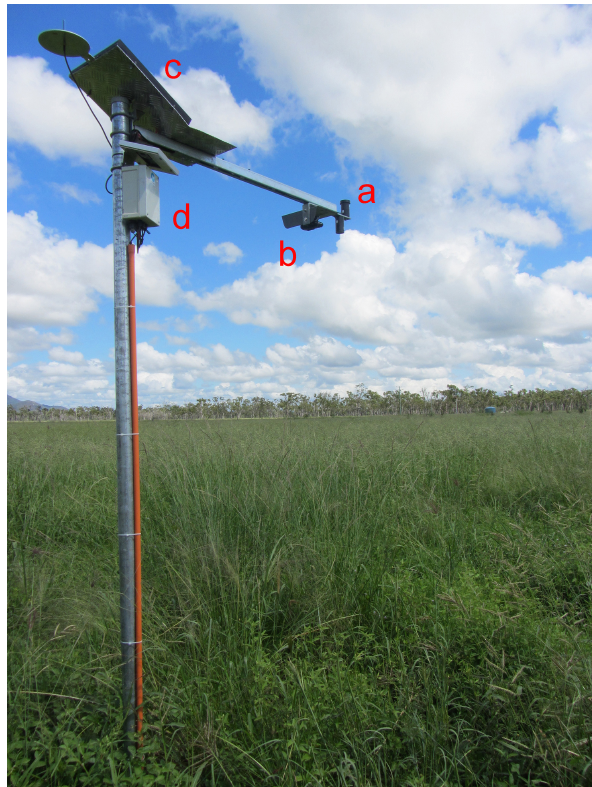
Figure 1. The unfenced node with (a) the paired multispectral sensors with the cosine diffusion filter fitted only to the upward- pointing sensor, (b) the digital camera, (c) the solar panel power supply, and (d) relay hardware to send data to the